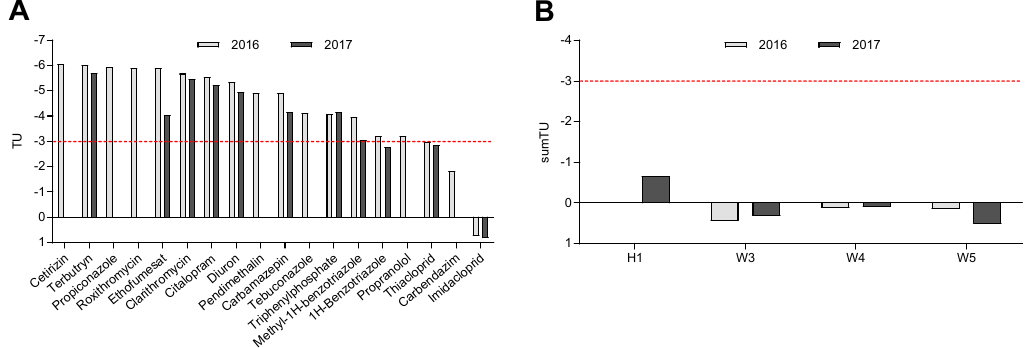
Figure 4. Toxic units (TUs) for single substances ( A ) and summarized TUs for each sampling site ( B ) for 2016 and 2017. For TUs above a value of − 3.0 (below the dashed red line), chronic effects can be expected.